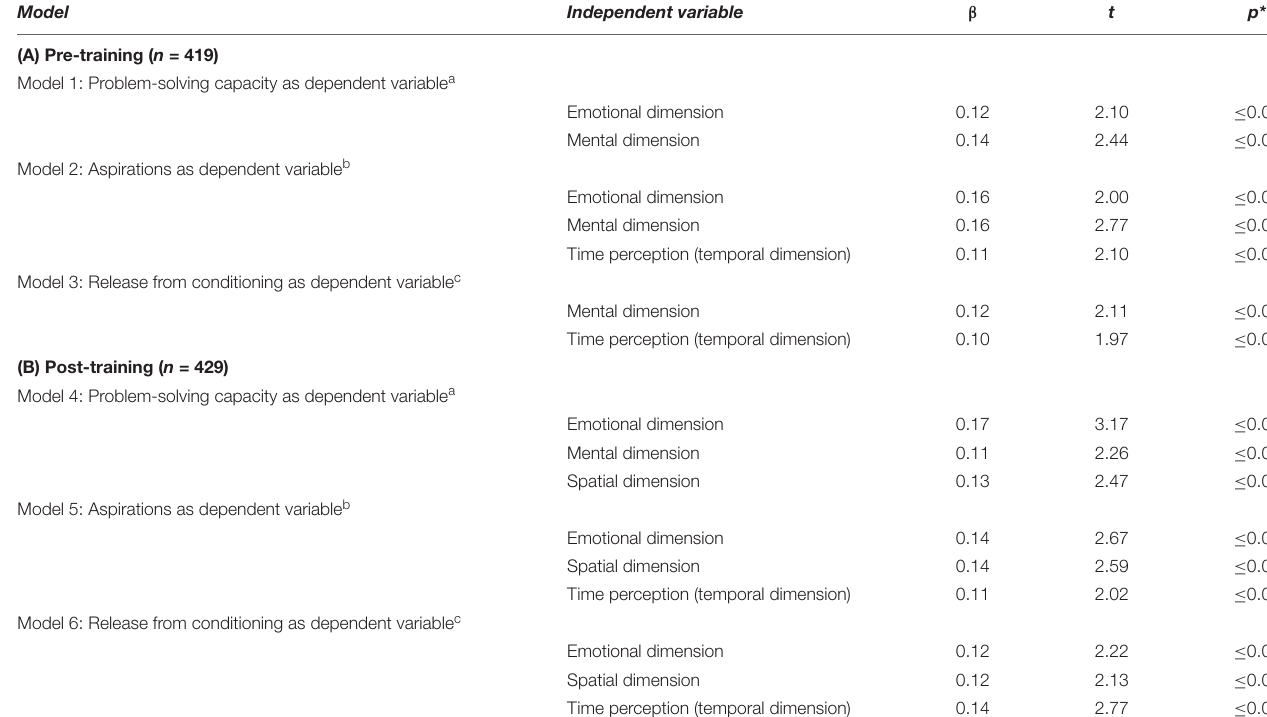
TABLE 2 | Multiple linear regression models with Sphere Model of Consciousness Meditation Practices Questionnaire self-determination measures as dependent variables. Model